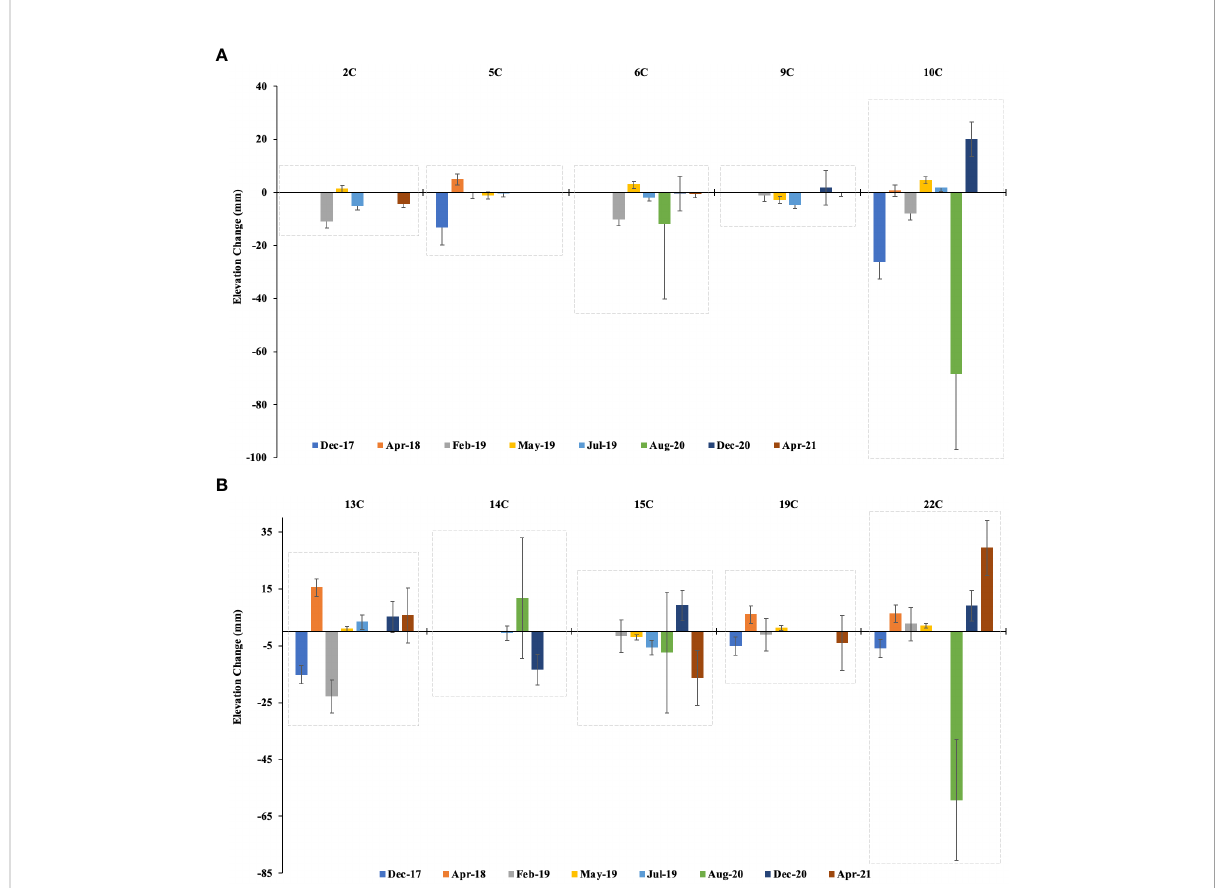
FIGURE 7 Mangrove surface elevation changes rates between Dec 2017 and April 2021 farther away from the main creek channel within the mangroves of Vanga at (A) stations 2C, 5C, 6C, 9C and 10C and (B) stations 13C, 14C, 15C, 19C and 22C. The top x-axis is the stations, while the bottom x-axis is the monitoring time stamps. Error bars represent the standard